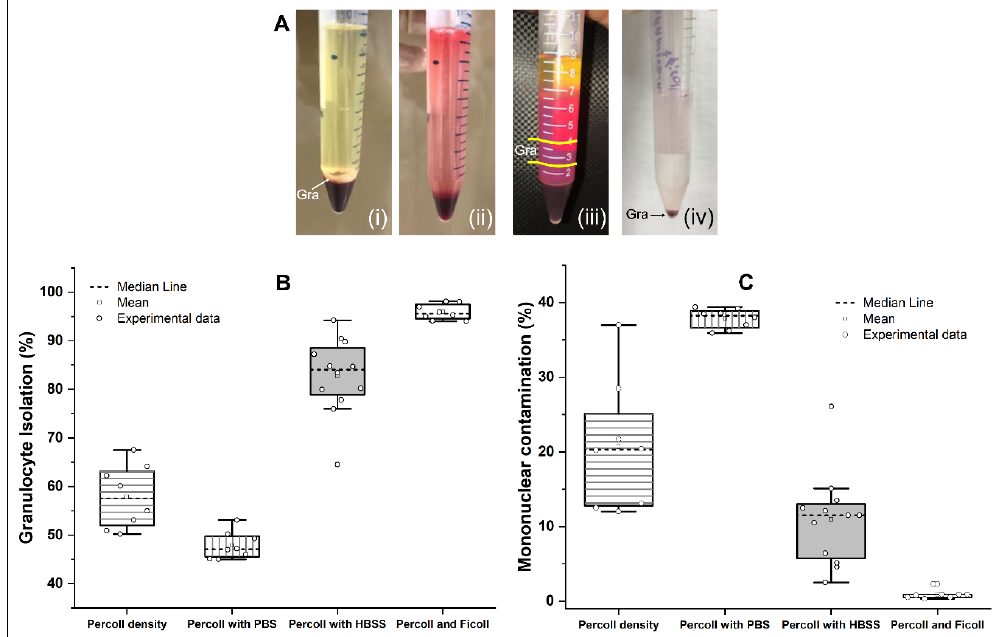
Table 4. Post hoc test — method comparisons.